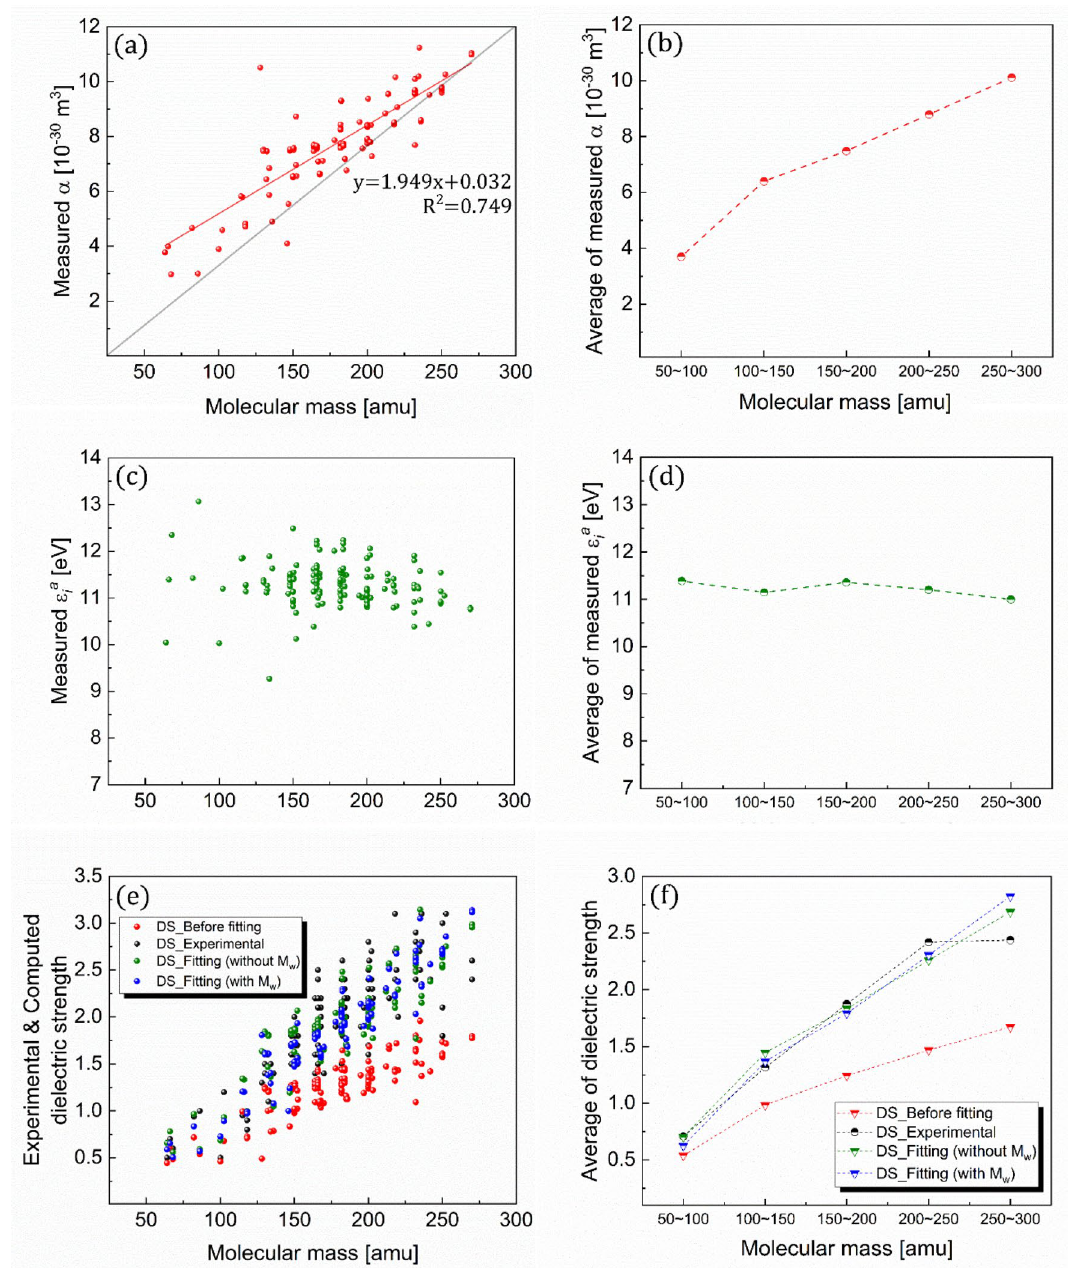
Figure 11. Correlations with physical property. ( a , b ) Polarizabilities, ( c , d ) ionization energies, and ( e , f ) dielectric strengths of the organic compounds correlated with their molecular